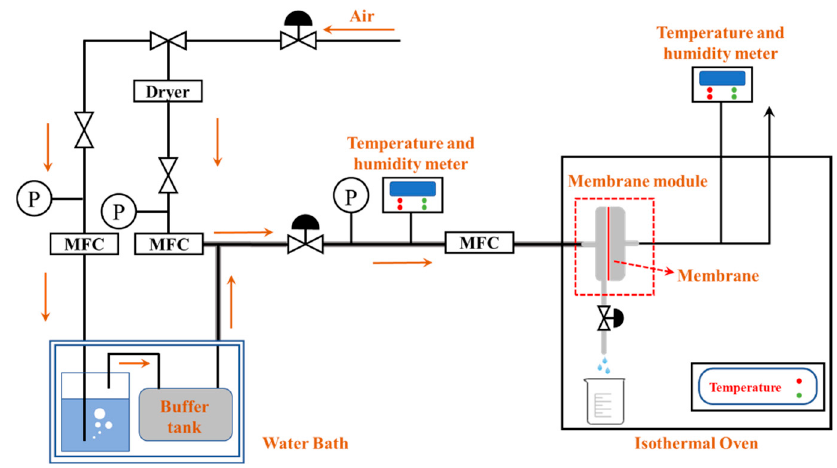
Figure 2. Membrane condenser experimental equipment. Table 3. Experimental parameters of membrane condenser tests.